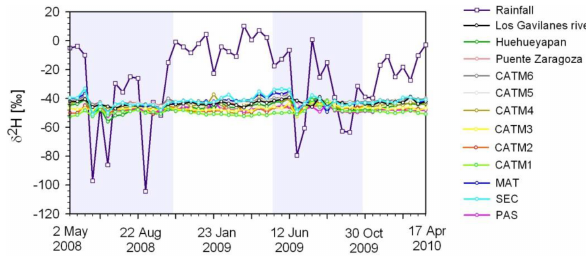
Figure 3. Bi-weekly values of δ 2 H composition of stream baseflow for each of the 12 study catchments, and corresponding values of deuterium composition of rainfall at 2400m (TG) for the period between May 2008 and April 2010. The shaded areas indicate the wet